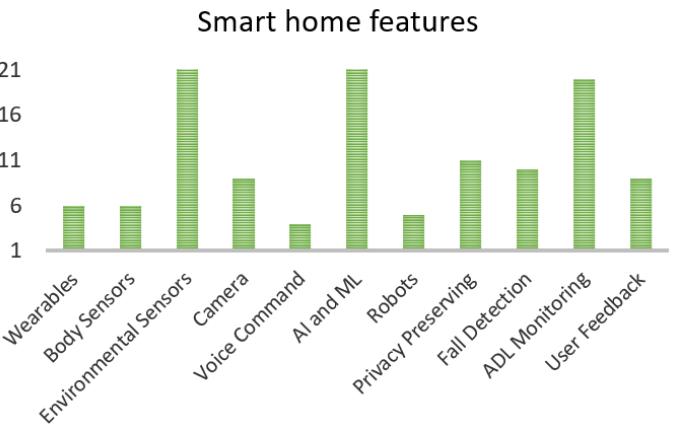
Figure 2. Smart home features in selected studies.